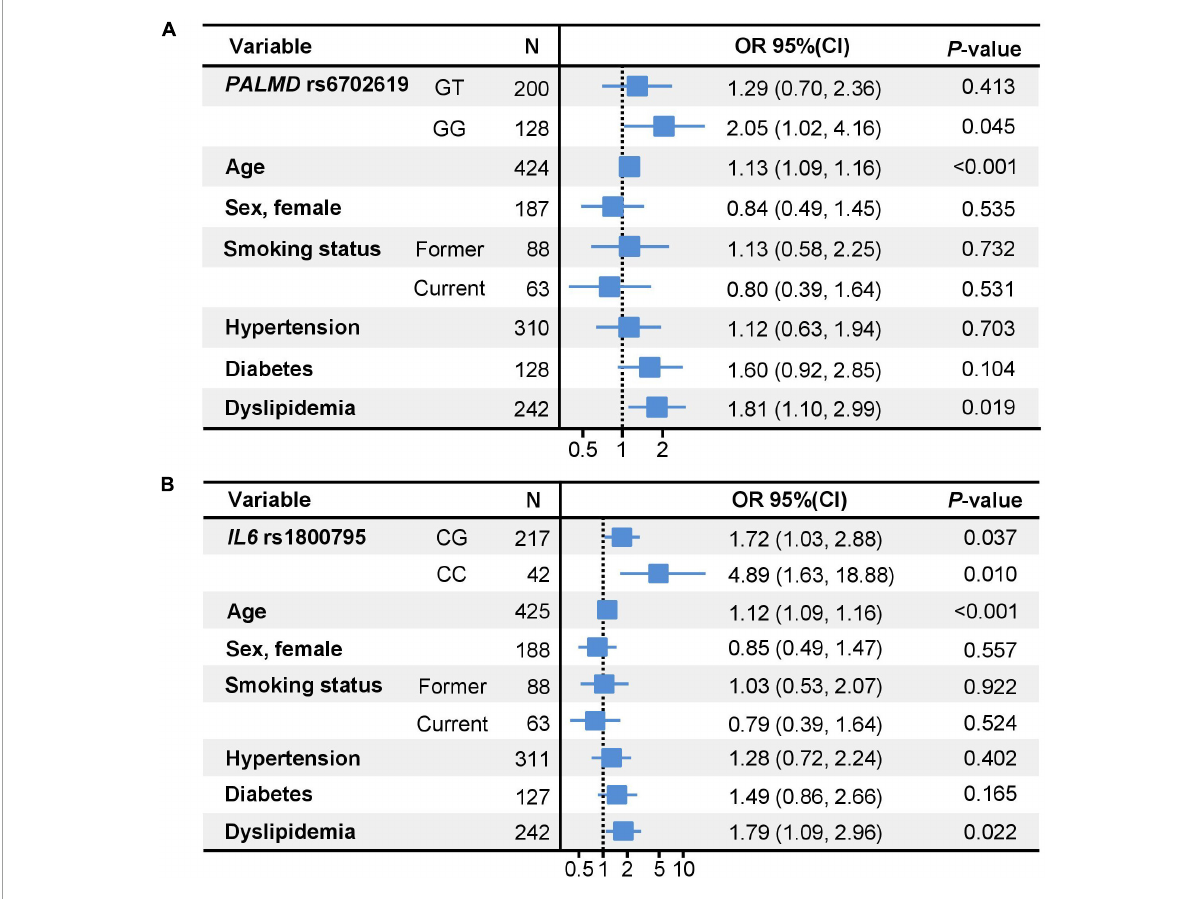
FIGURE2 Forest plots showing the multivariable logistic regression models for the association between PALMD (A) and IL6 (B) genotypes and aortic stenosis. Reference for smoking status: never smoked. Reference for PALMD rs6702619 polymorphism (A) : TT genotype. Reference for IL6 rs1800795 polymorphism (B) : GG genotype; OR, Odds Ratio; CI, Confidence